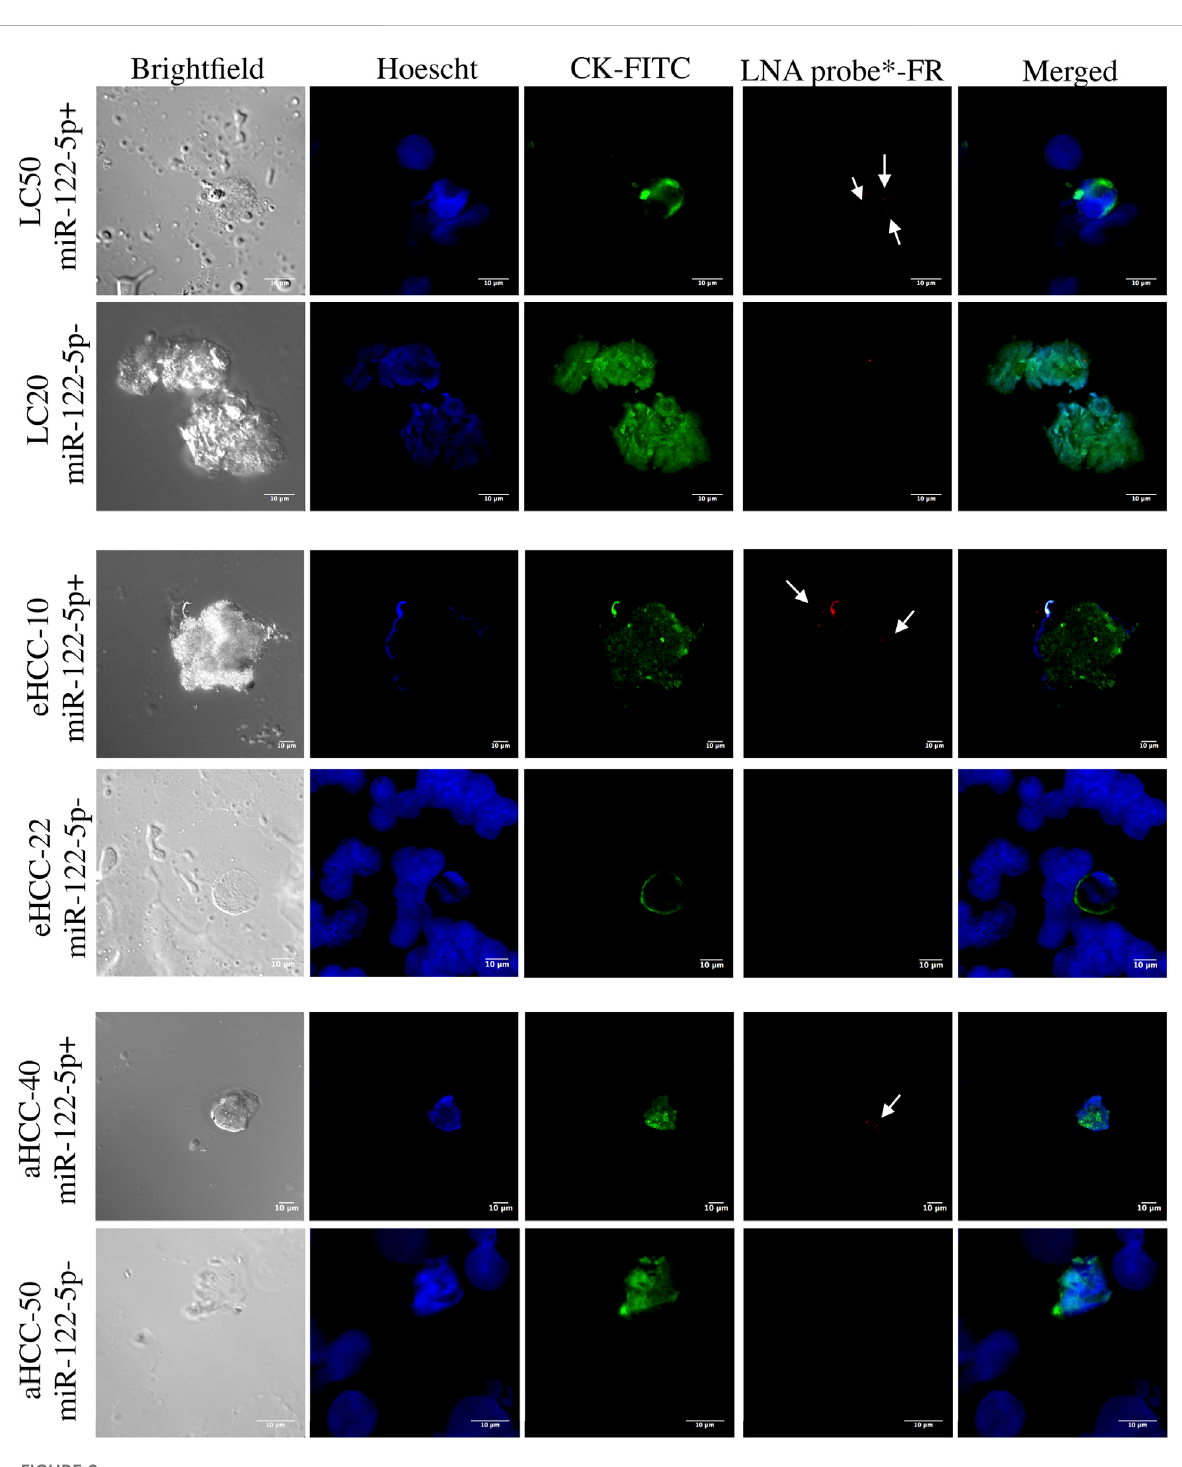
FIGURE 2 Confocal microscopy of immunoFISH for miR-122-5p in patients with liver cirrhosis or HCC. Cytokeratin (CK) is shown in green (FITC) and miR122-5p probe is shown in red. Data from two patients for each group: liver cirrhosis (LC; top), early HCC (eHCC; middle) and advanced HCC (aHCC; bottom) are shown. For each patient group, a positive miR-122-5p signal (coinciding with positive ASGR1 staining) and a negative miR-122- 5p signal (coinciding with negative ASGR1 staining) are